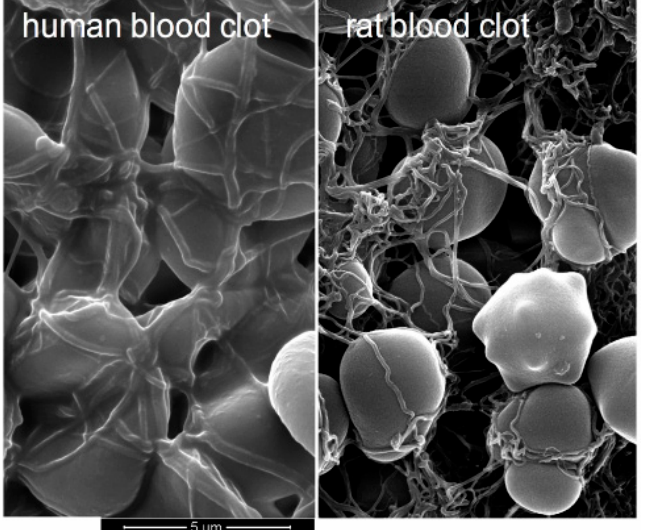
Figure 2. SEM of fully formed human and rat blood clots at 15,000 × magnification. Rat fibrin fibers are thinner and more contorted, even if they bind to RBCs, and the fiber meshwork is denser. Note that the human RBCs are species-specifically